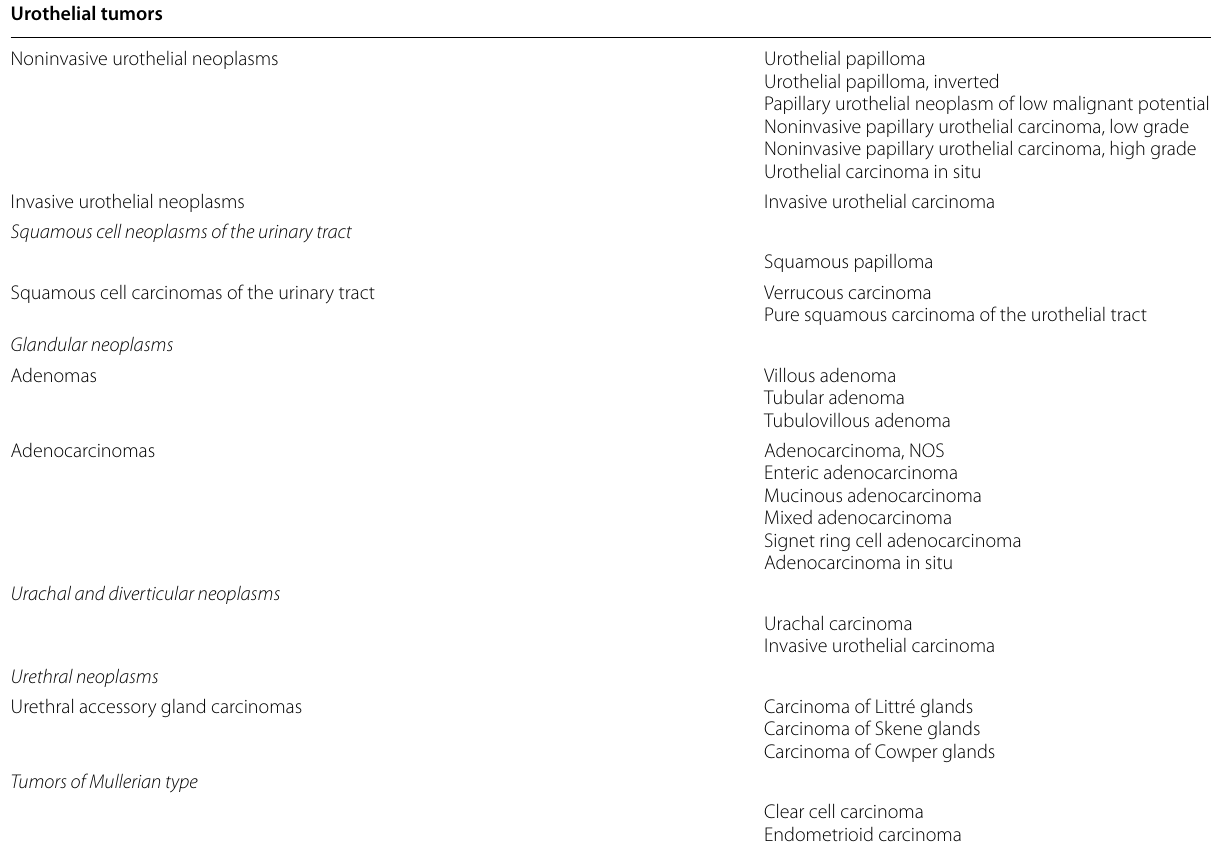
Table 1 The 2022 WHO classification of urinary tract tumors Urothelial